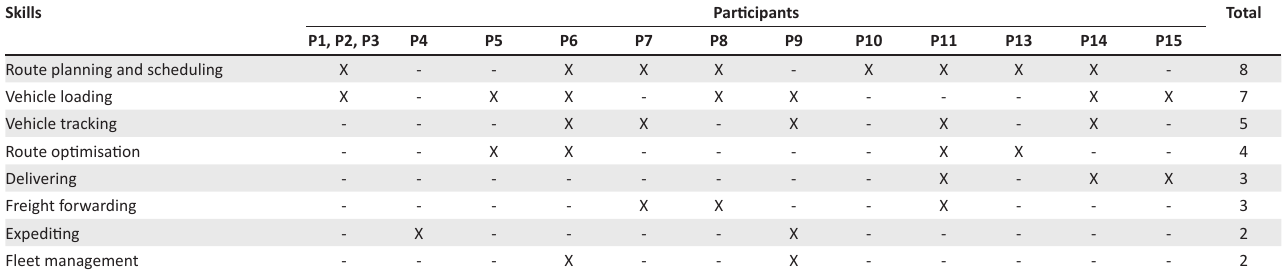
TABLE 6: The industry’s expectations concerning transportation skills. Skills Route planning and scheduling Vehicle